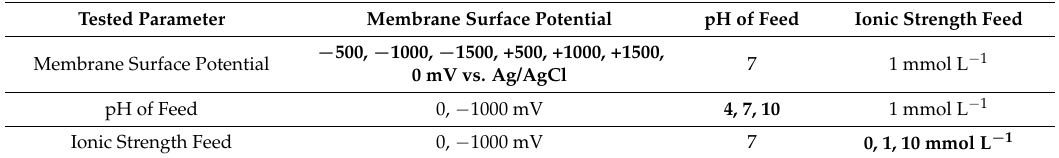
Table 1. Parameters of filtration